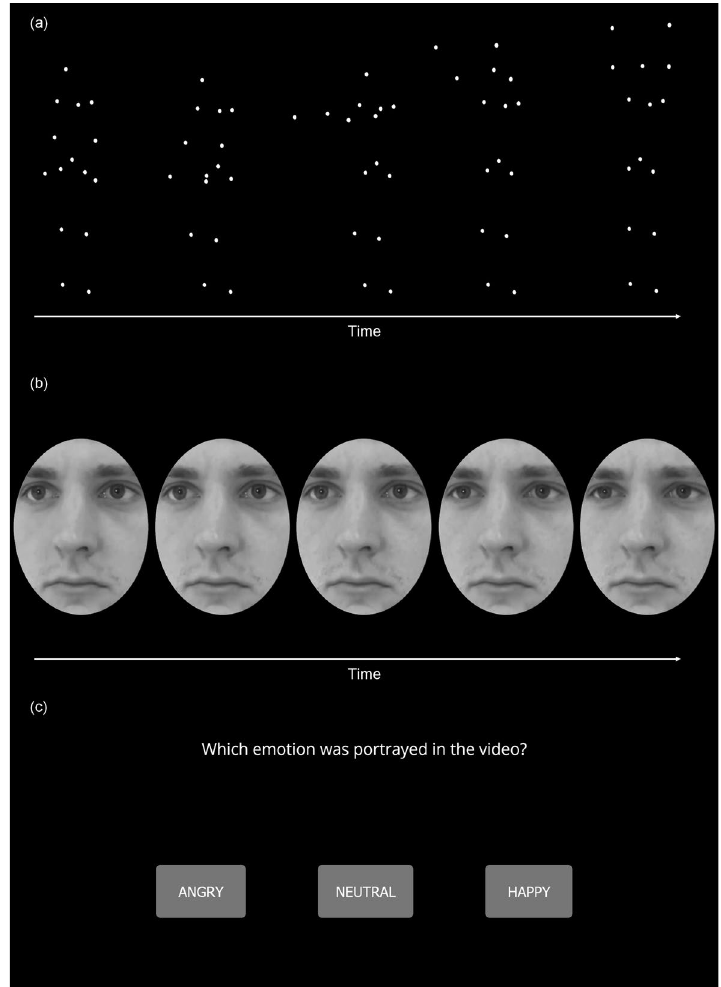
Figure 1. Examples of static frames of dynamic videos. ( a ) EmBody stimulus of the scale Happy showing a “La Ola” wave motion, ( b ) EmFace stimulus of the scale Angry, ( c ) the response window prompting participants to select the emotion they believe was portrayed in the preceeding EmBody or EmFace stimulus. Dynamic versions of the respective stimuli can be found online in the supplemental materials of this